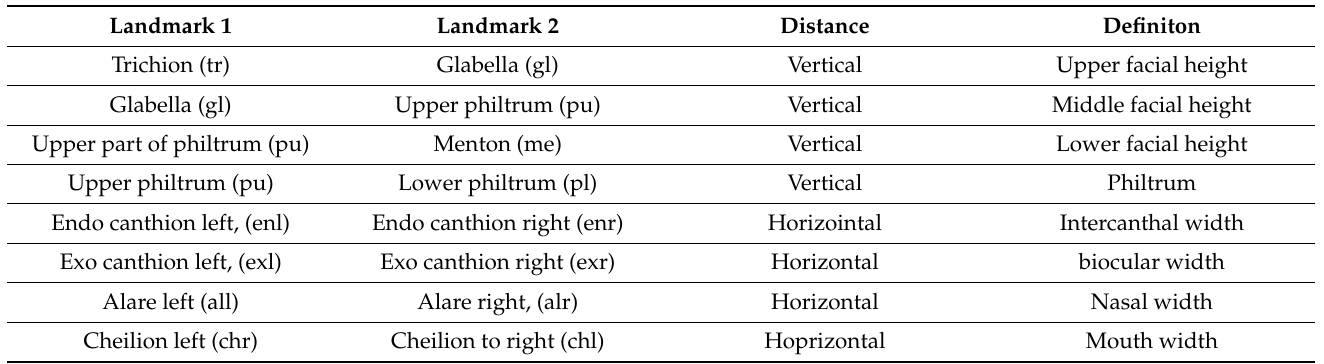
Table 1. Facial landmarks and anthropometric